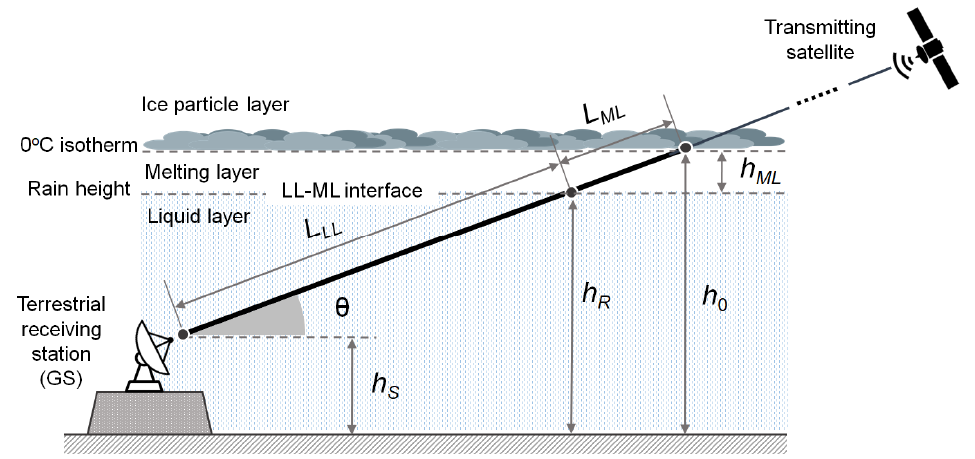
Figure 4. Satellite downlink geometry in the presence of stratiform rain and three-layer tropospheric model.